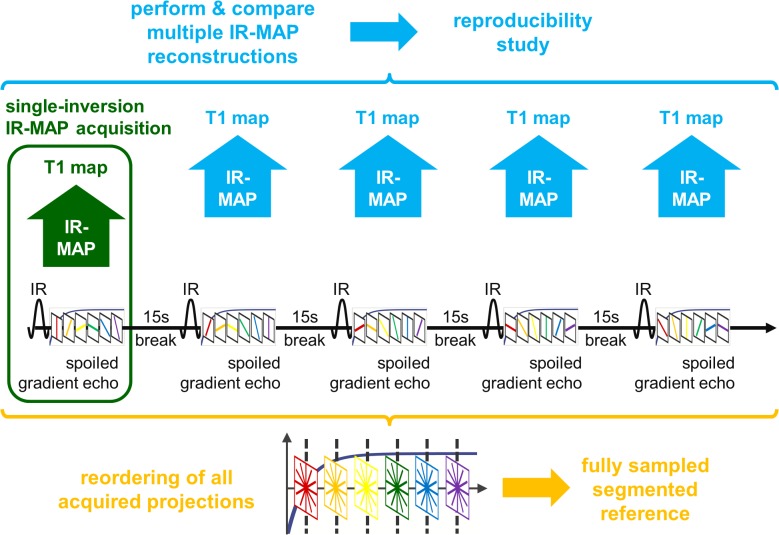
Acquisition scheme of all acquisitions performed in this work.The regular IR-MAP acquisition consists of one inversion followed by a spoiled gradient-echo data collection (green). The segmented reference is acquired by performing multiple IR-LL acquisitions, each of which is followed by a 15s break for relaxation before the next inversion (orange). Using IR-MAP reconstructions for multiple of the acquired IR-LL datasets, a reproducibility study was carried out (blue).